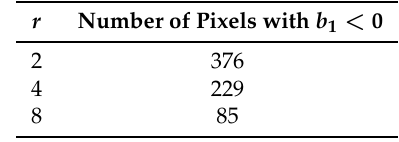
Table 3. The effect of r to the determination of b 1 for the conventional LF population model.